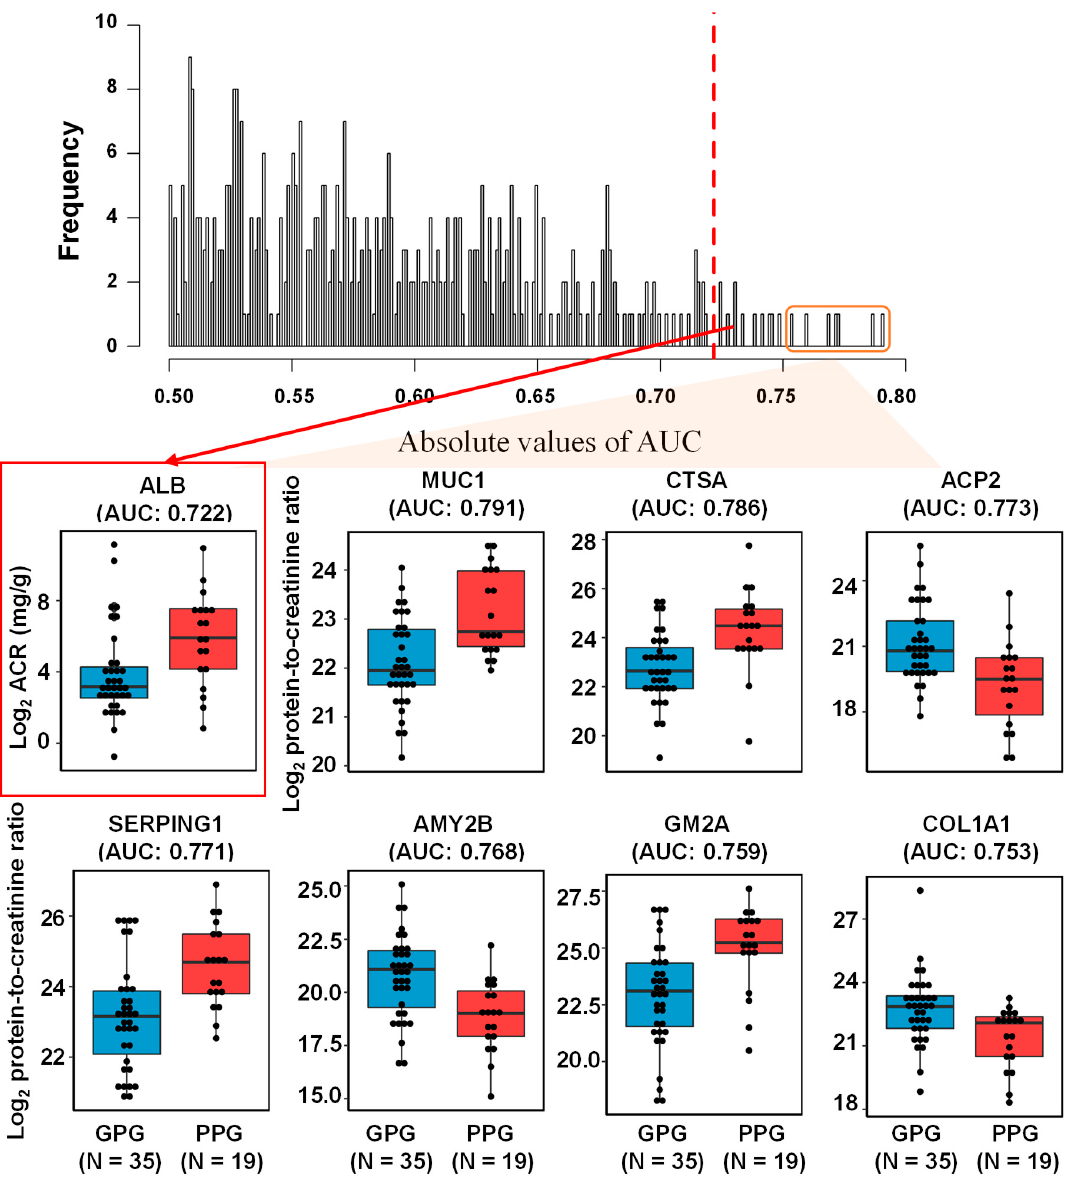
Figure 5. Histogram of area under the ROC curves (AUC) of 412 urinary proteins and ACR. Top seven proteins (MUC1, CTSA, ACP2, SERPING1, AMY2B, GM2A, and COL1A1) and ACR are represented with box plots.